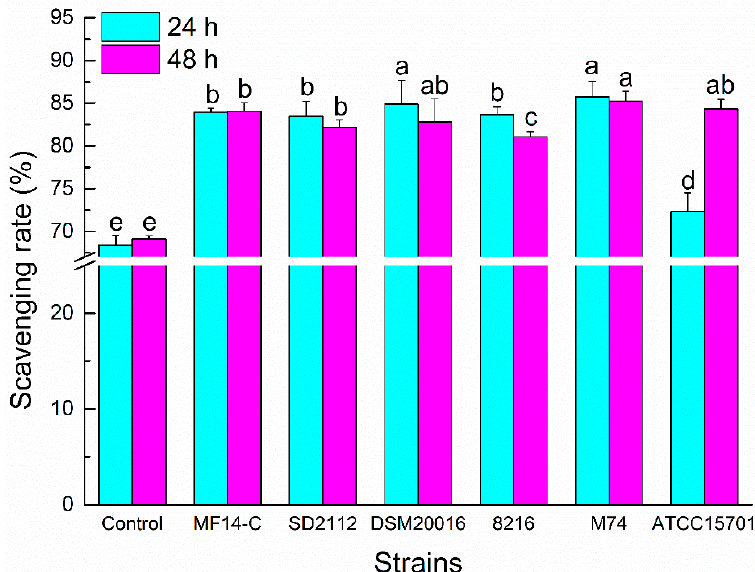
Figure 3. 1,1-diphenyl-2-picryl-hydrazyl (DPPH) radical scavenging activity of PLSE fermented by six strains of probiotic bacteria at 37 °C for 24 h and 48 h. Different superscript small letters (a, b, c, d, and e) are significantly different ( P < 0.05).